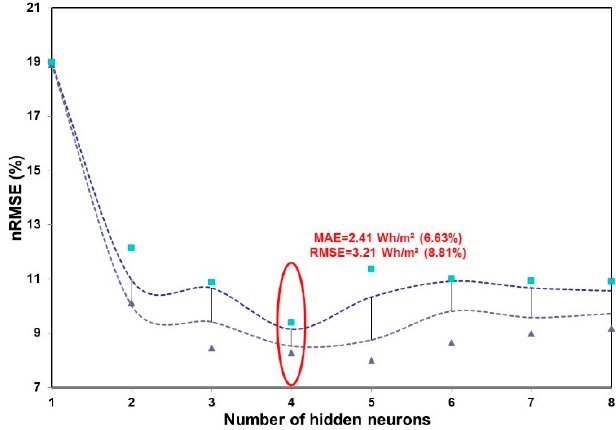
Figure 7. nRMSE evolution vs the number hidden neurons (Bouzareah site).